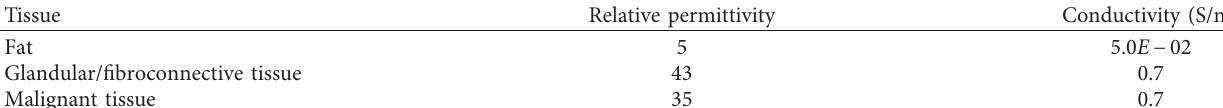
Table 1: Dielectric properties of breast tissues at 2GHz [14, 15].